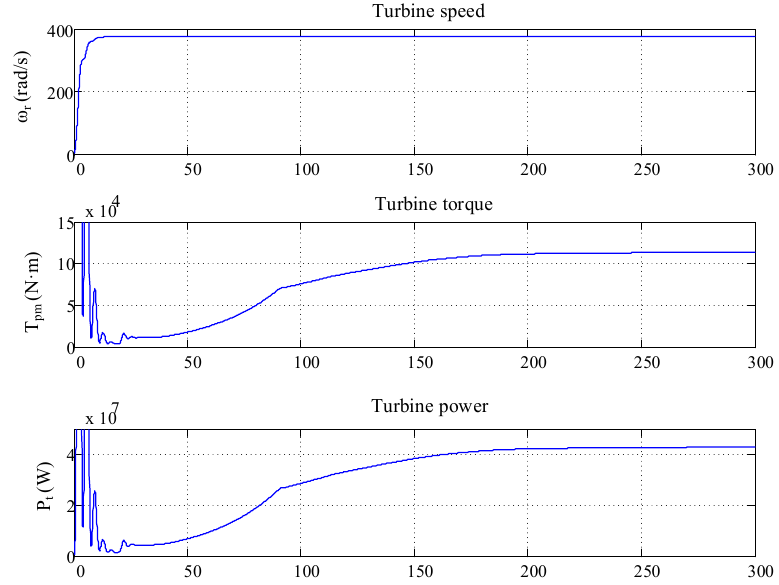
Figure 4. Case 1 gas turbine speed, torque, and power.